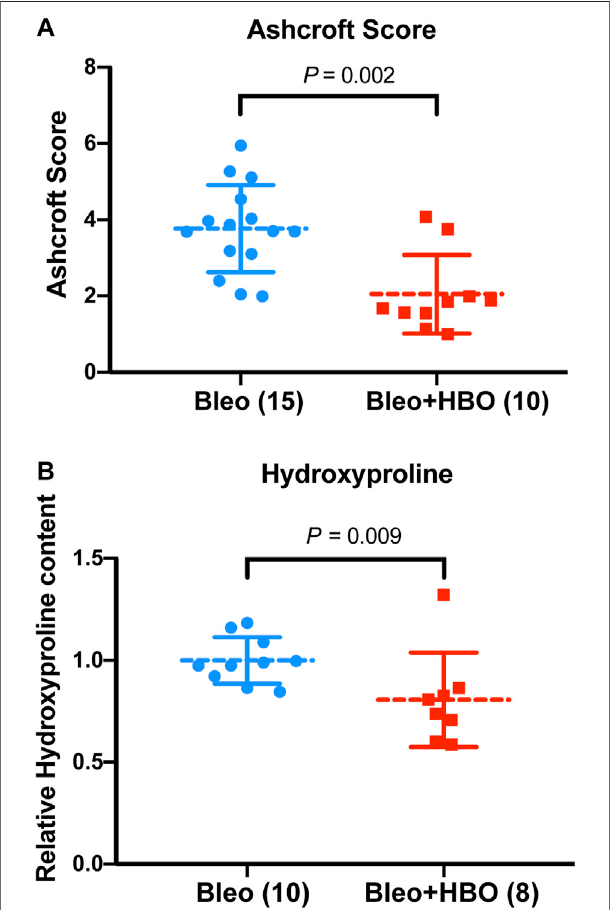
FIGURE 3 | Repetitive HBO treatments attenuate bleomycin-induced pulmonary fi brosis in mice. (A) Ashcroft scores in lungs from bleomycin- challengedmice(Bleo)orbleomycin-challengedmicetreatedwithrepetitive HBO (Bleo + HBO). Numbers of mice within each group and the p value are indicated. (B) Graph showing the relative hydroxyproline content in lungs from bleomycin-challenged mice (Bleo) or bleomycin-challenged mice treated with repetitive HBO (Bleo + HBO). Lung tissue mass – normalized hydroxyproline levels in the Bleo group were used to set the baseline value at unity. Data are mean ± s.d., with numbers of mice within each group and the p value indicated. Data in (A) were analyzed with the unpaired t -test. Data in (B) were analyzed with the nonparametric t -test (Mann – Whitney test).